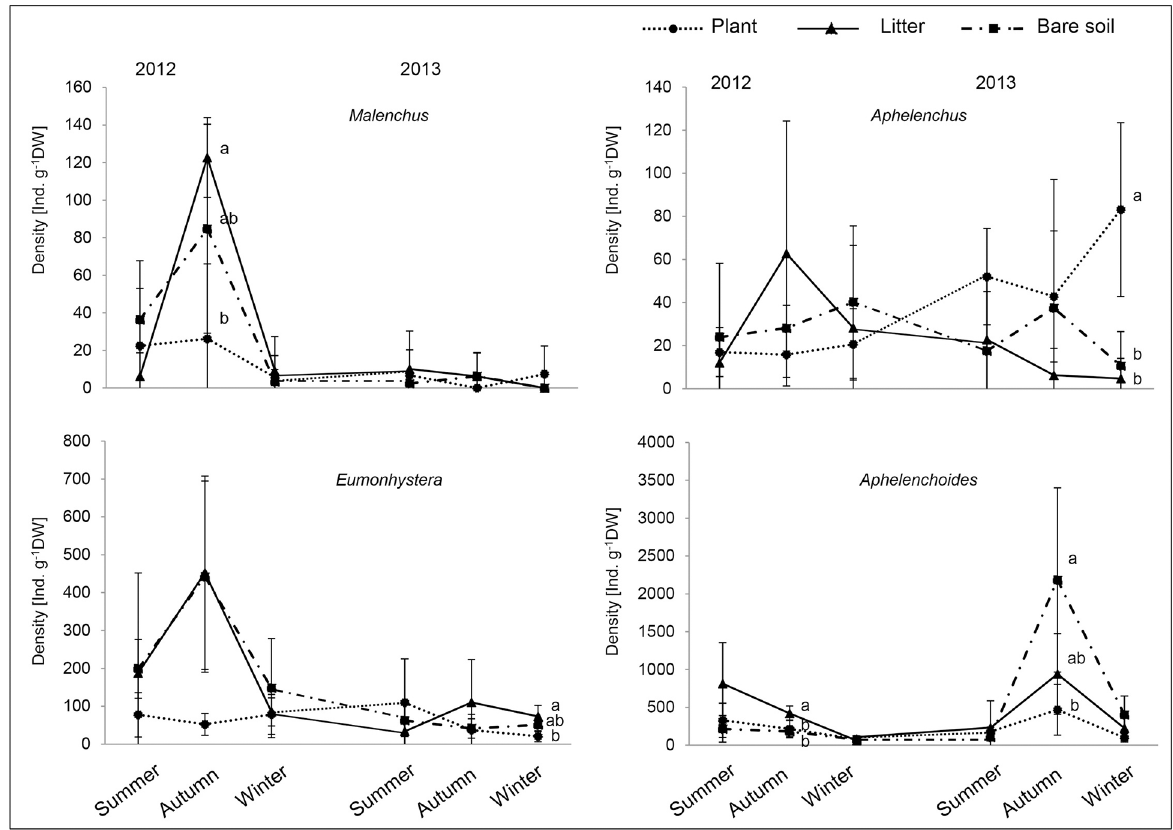
Fig 4. Occurrenceof the root-feeding Malenchus , the bacteria and unicellular eukaryotefeeding Eumonhystera , and the fungal-feeding Aphelenchus and Aphelenchoides in soil cropped with maize (plant), amended with maize shoot litter (litter) or bare soil. Abundance (individuals100 g -1 dry weight soil ± SD) is given in topsoil(0–10 cm), rooted zone (40–50cm), and root free zone (60–70cm) in the years 2012and 2013. Values within a samplingdate with the same or no letters are not significantly different according to Tukey’s HSD test at P <